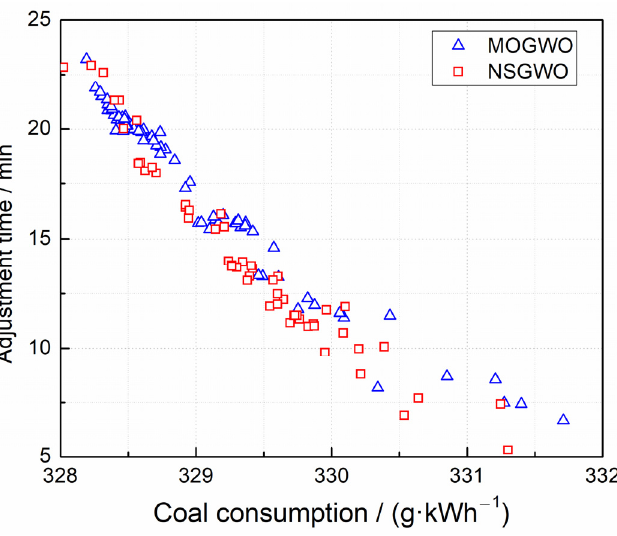
Figure 6. Pareto fronts of coal consumption and adjustment time of load-dispatch optimization for coal-fired power plant with 10 similar-scale units under NSGWO and MOGWO algorithms.